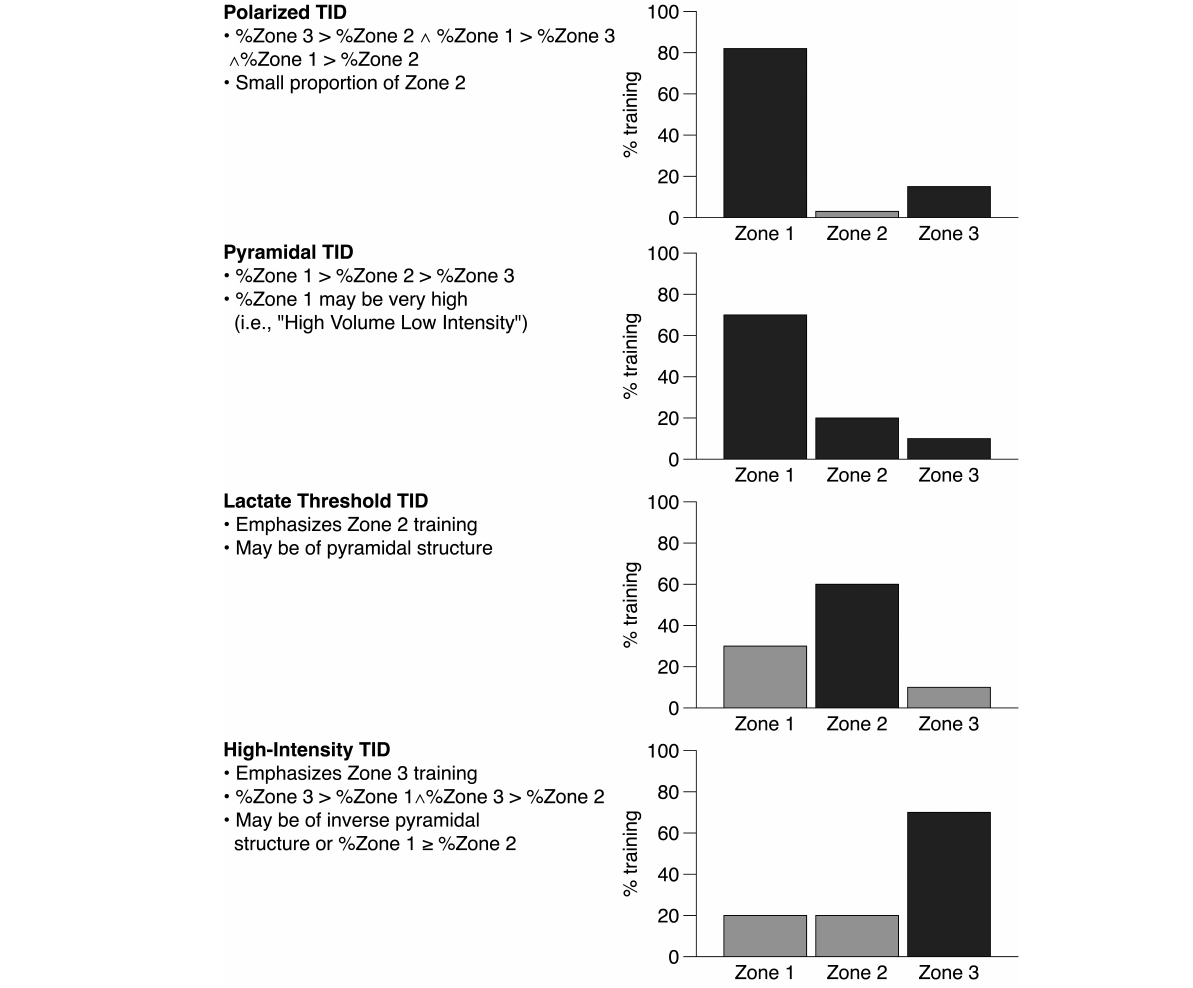
FIGURE 1 | Various training intensity distributions (TID), their schematic proportions, and key characteristics (indicated by black bars). Zones refer to following intensities: Zone 1 (basic endurance), ≥ 50% ˙VO 2max and ≤ first lactate or ventilatory threshold; Zone 2 (lactate threshold), ≥ first and ≤ second lactate or ventilatory threshold; Zone 3 (high intensity), > second lactate or ventilatory